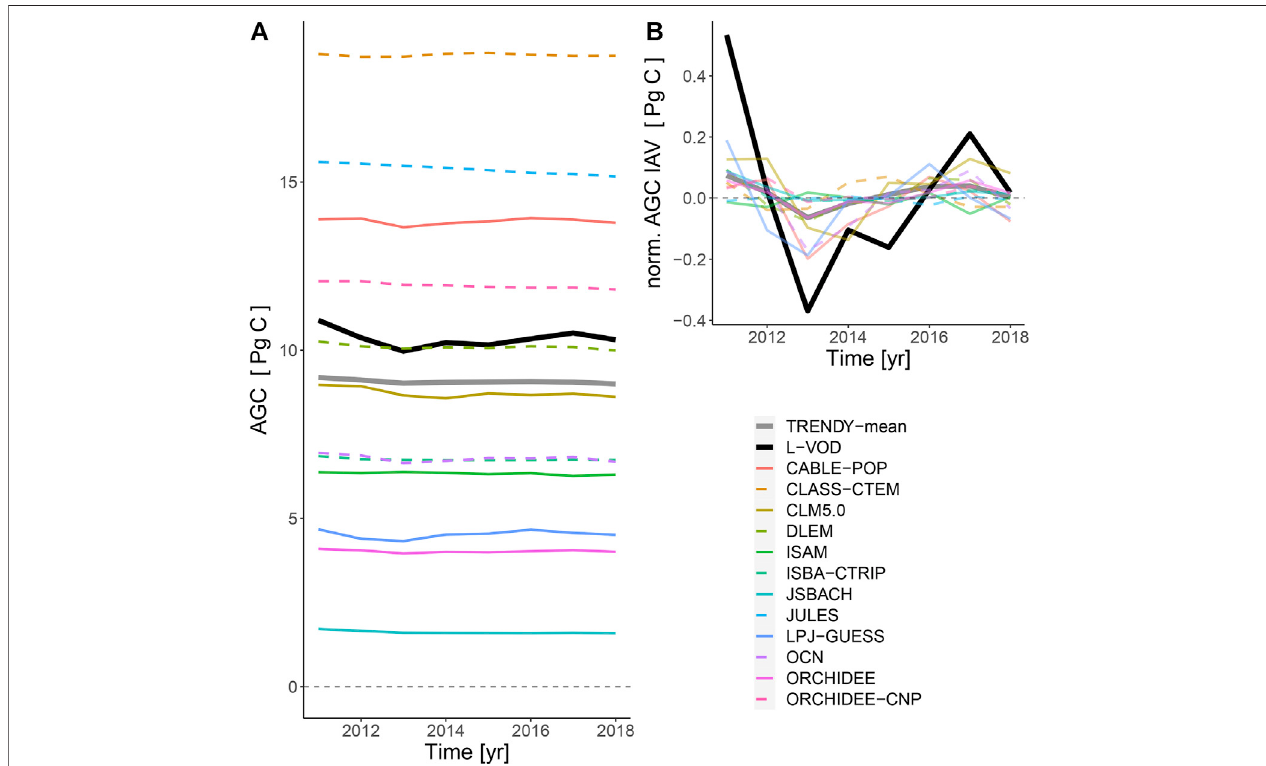
FIGURE 5 | (A) Time-series of aboveground carbon (2011 – 2018) in African, American and Australian drylands for the retrieval (black bold line) and models of the TRENDYensemble.TherewassubstantialbiasbetweenmostmodelsandmodelswerelesssensitivetotemporalchangesinAGCcomparedtotheL-VODretrieval. (B) The mean-normalised detrended time series show weak agreement in interannual differences for all models.